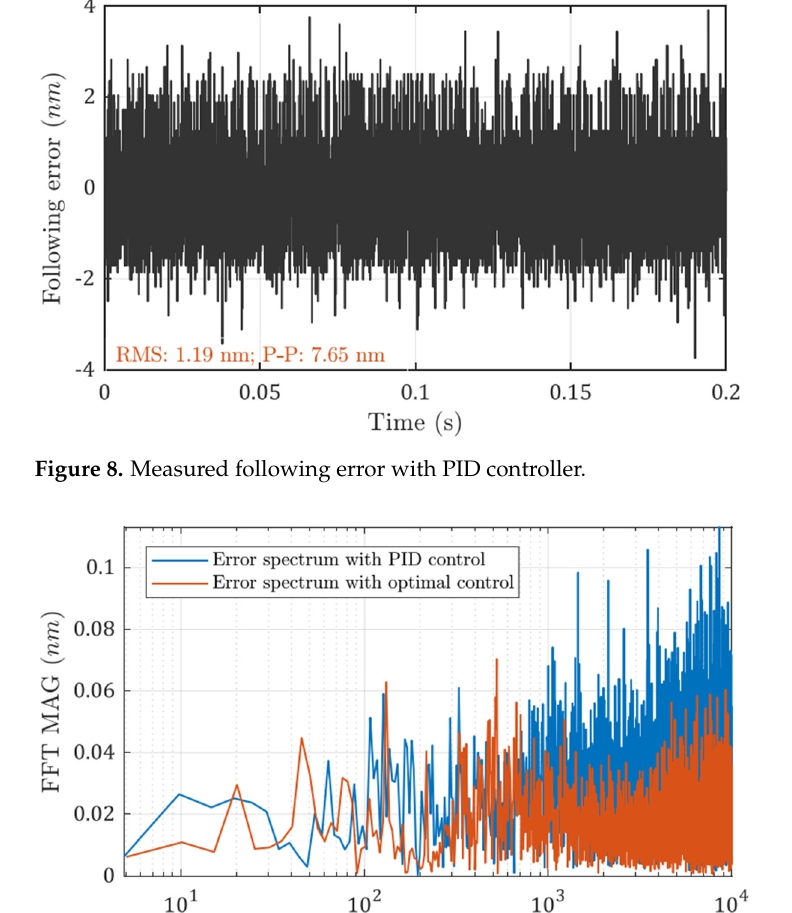
Figure 7. Measured following error with optimal controller at a bandwidth of 1.1 kHz.